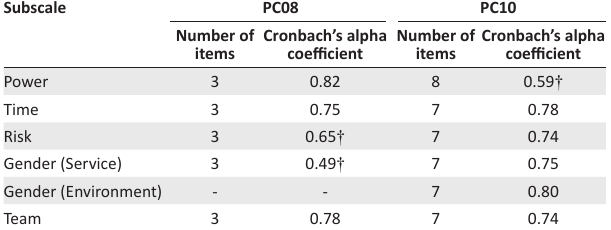
TABLE 2: PC08 (Herkenhoff, 2010) and PC10 subscale